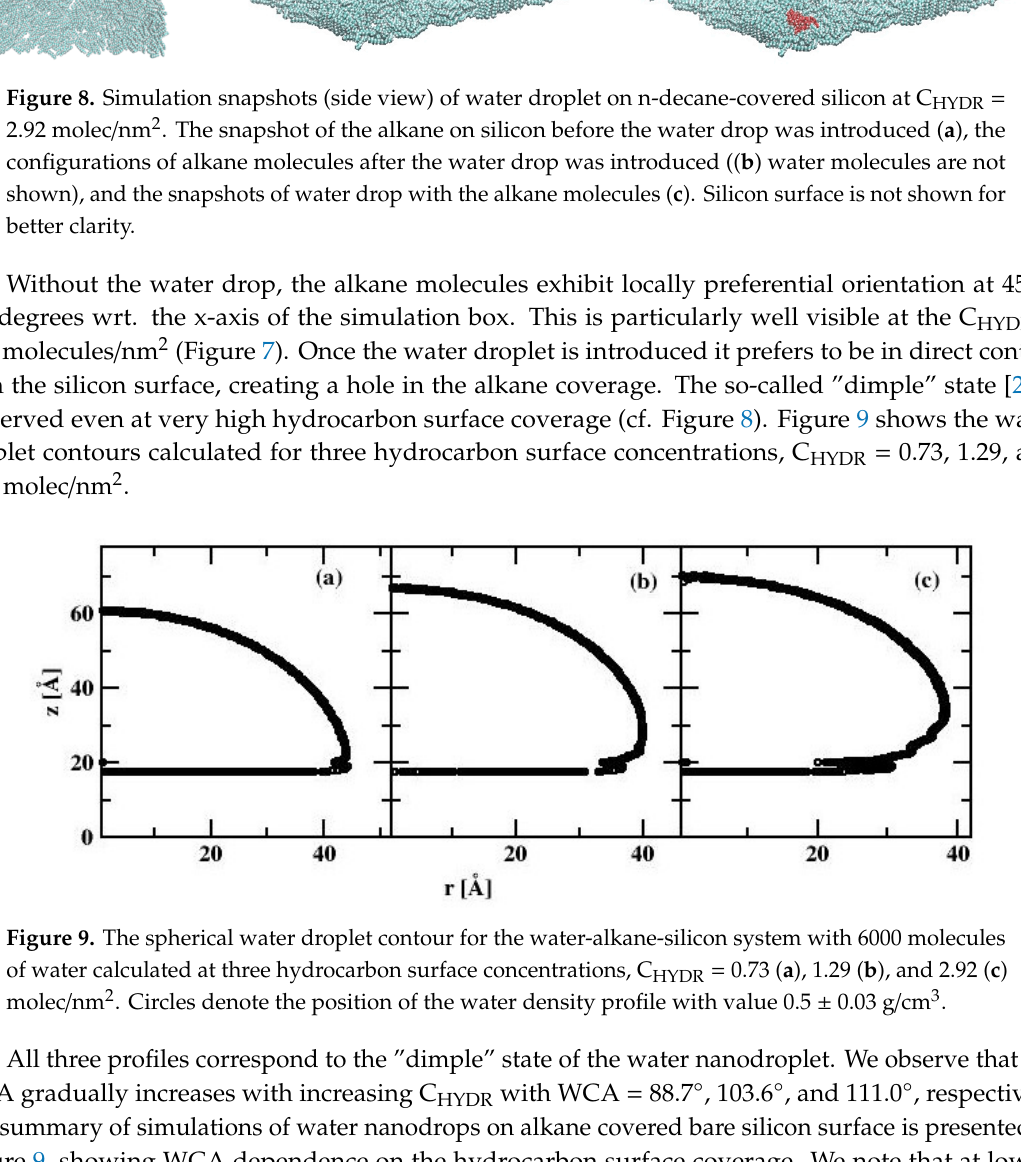
Figure 9. The spherical water droplet contour for the water-alkane-silicon system with 6000 molecules of water calculated at three hydrocarbon surface concentrations, C HYDR = 0.73 ( a ), 1.29 ( b ), and 2.92 ( c ) molec/nm 2 . Circles denote the position of the water density profile with value 0.5 ± 0.03 g/cm 3 .